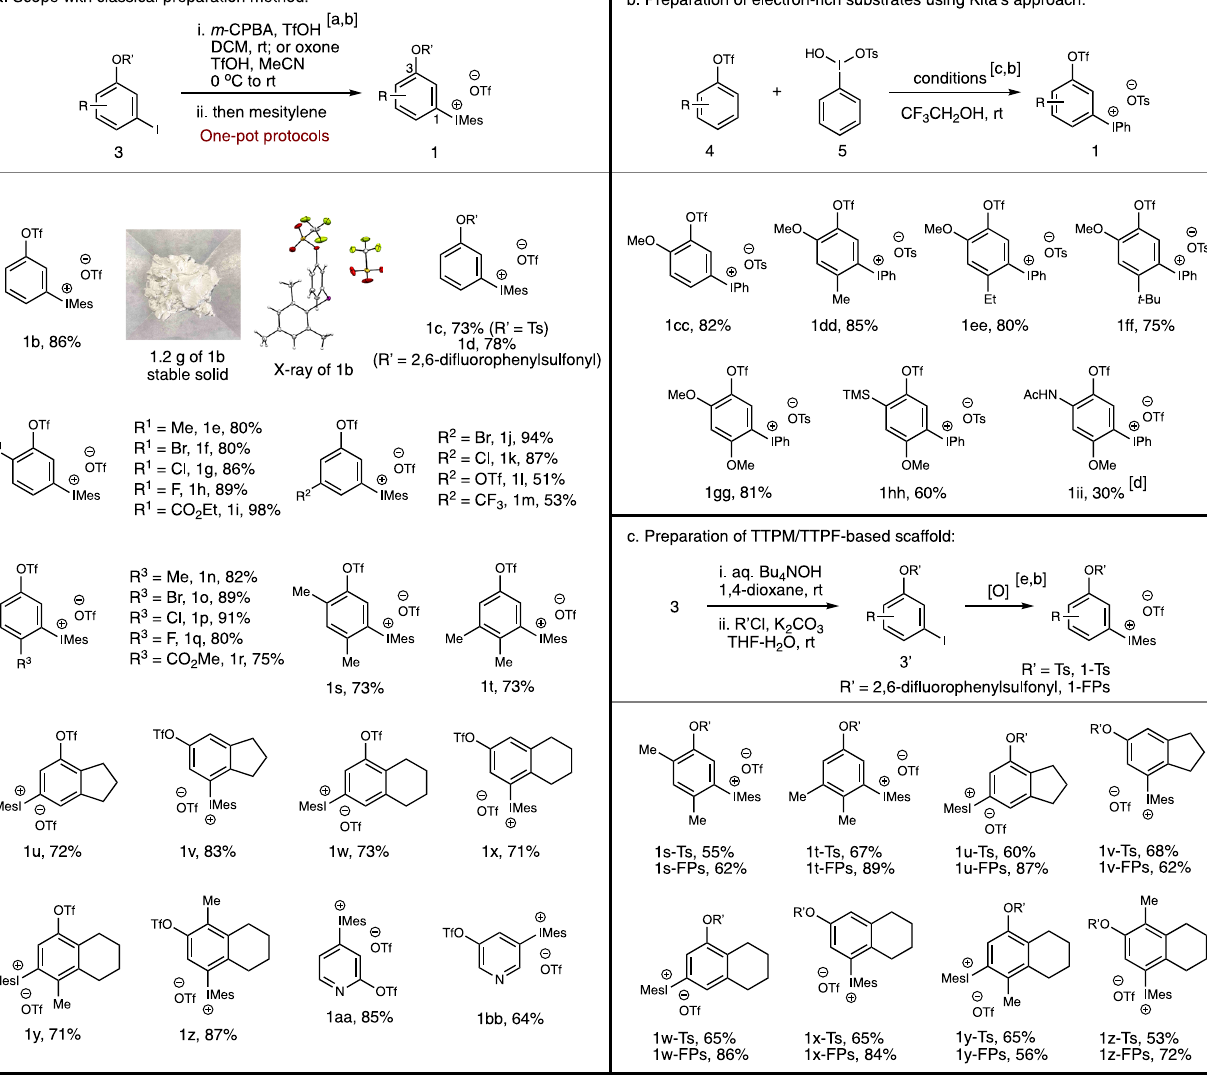
Fig. 3 | Scope for domino aryne precursors. a Scope with classical preparation method. b Preparation of electron-rich substrates using Kita ’ s approach. c Pre- paration of TTPM/TTPF-based scaffold. Reaction conditions: [a] A solution of 3 (1.0mmol), m -CPBAorOxone(1.5mmol),tri fl icacid(2.0mmol)insolvent(5.0mL) was stirred from 0 o C to rt for 3hours; mesitylene (1.1mmol) was then added.